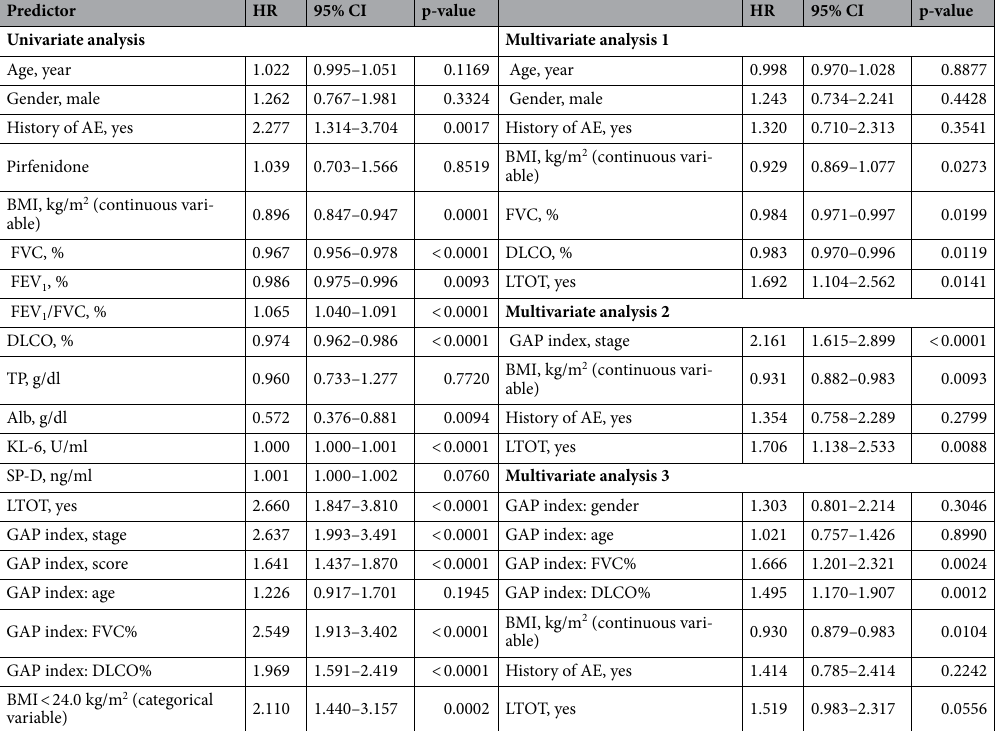
Table 4. Prognostic factors in 229 patients with IPF treated with antifibrotic therapy by univariate and multivariate Cox-proportion analyses. AE acute exacerbation, BMI body mass index, FVC forced vital capacity,